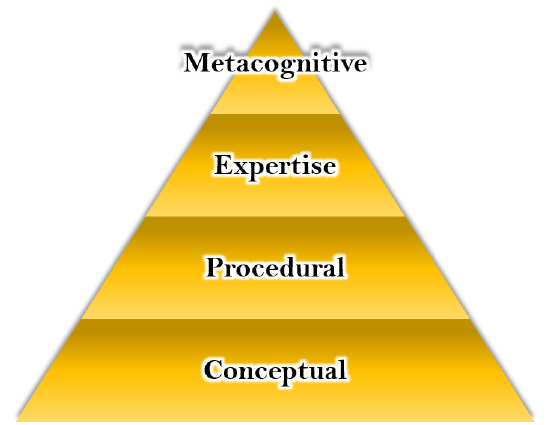
Figure 6. Maturity echelons of the knowledge system